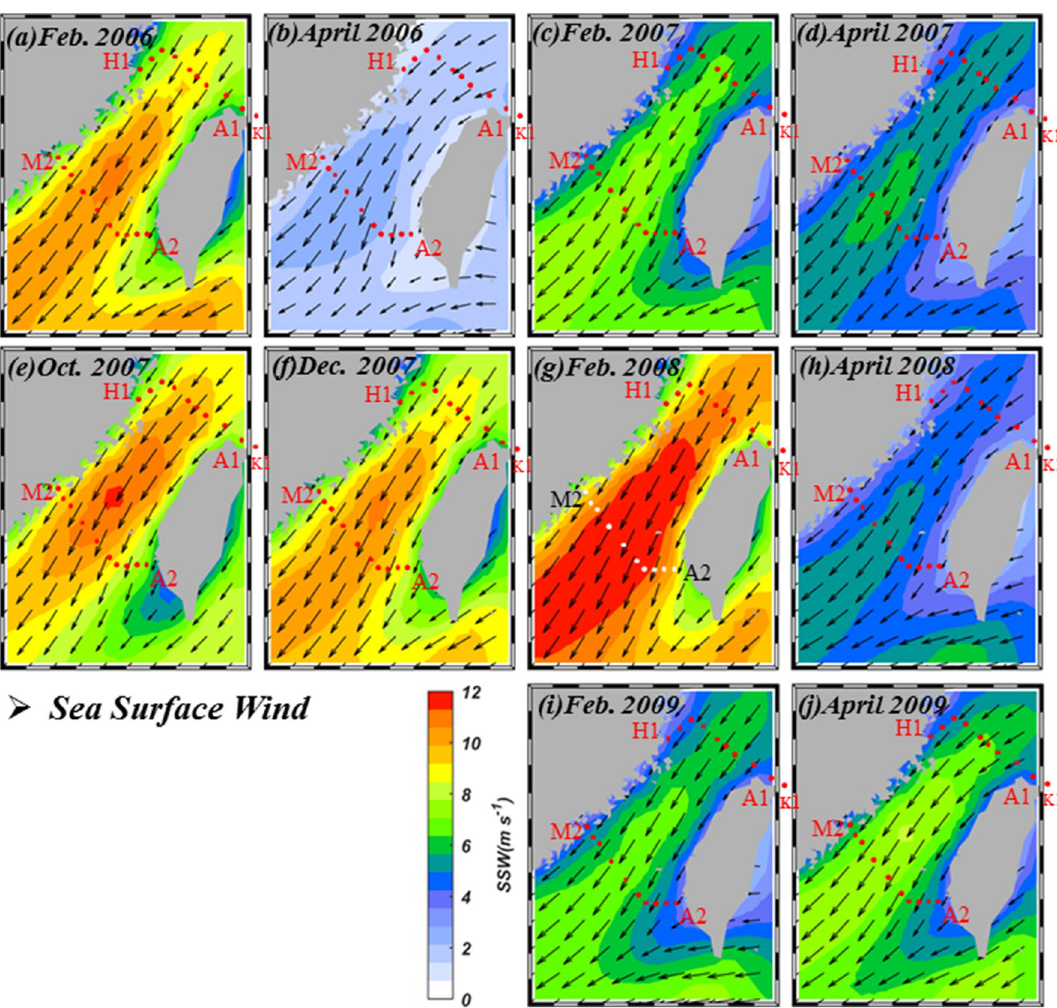
Figure 6. Mean sea surface wind in ( a ) Feb. 2006, ( b ) April 2006, ( c ) Feb. 2007, ( d ) April 2007, ( e ) Oct. 2007, ( f ) Dec. 2007, ( g ) Feb. 2008, ( h ) April 2008, ( i ) Feb. 2009 and ( j ) April 2009 in the vicinity of the study area (map generated by using the m_map toolbox in MATLAB 2019a; https ://www.mathw